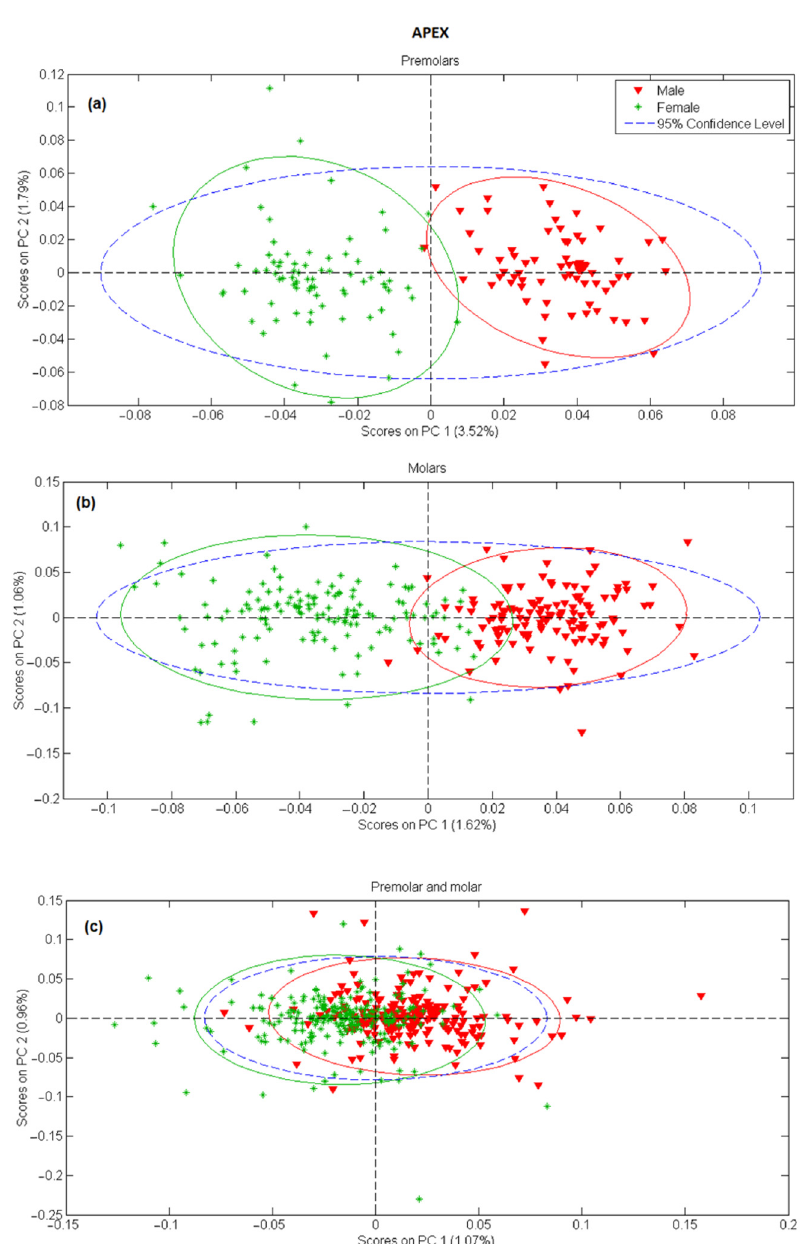
Figure 2. PC1 versus PC2 score plot resulting from the decomposition of Raman data obtained on tooth apex in the 3500–200 cm − 1 range for: ( a ) premolars, ( b ) molars, ( c ) premolars and molars.